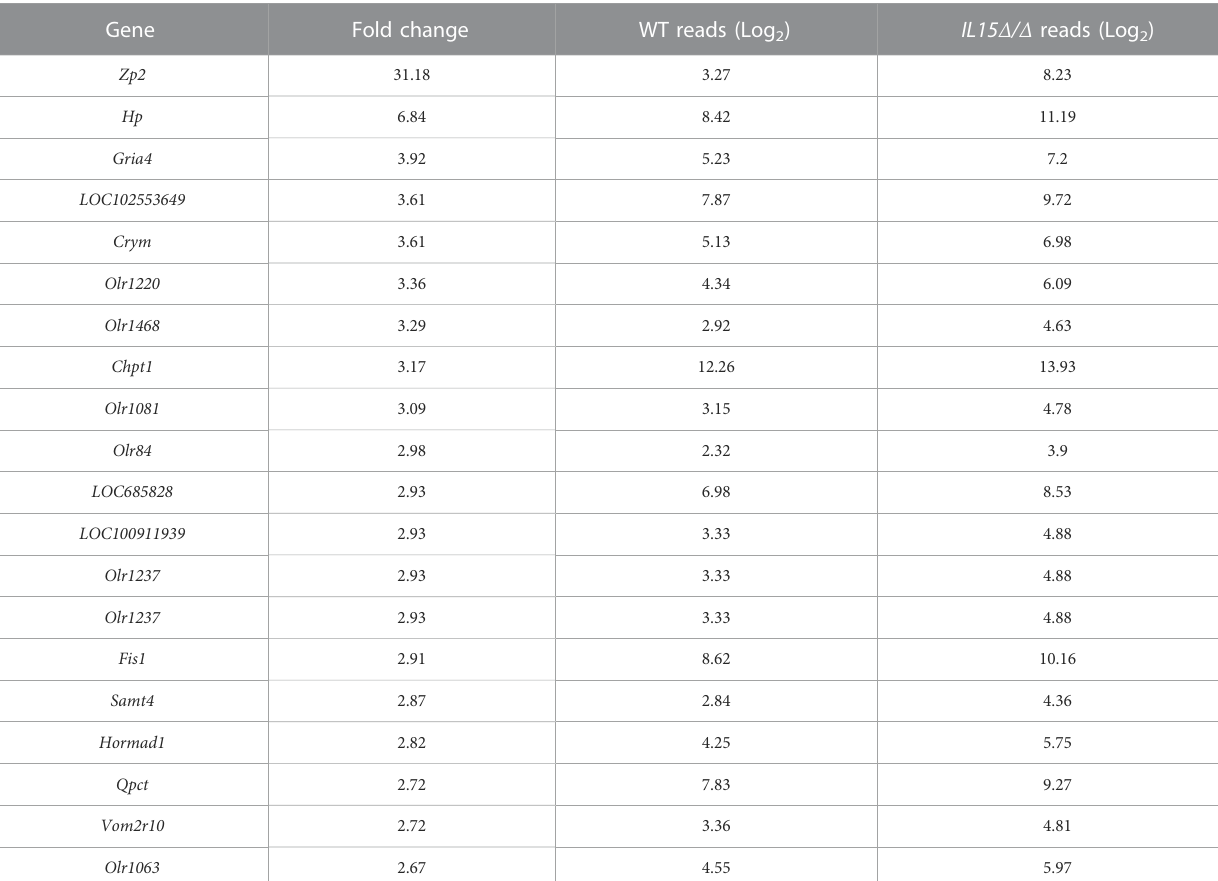
TABLE 2 List of top 20 upregulated genes in IL15 Δ / Δ rat conceptuses. Gene Fold